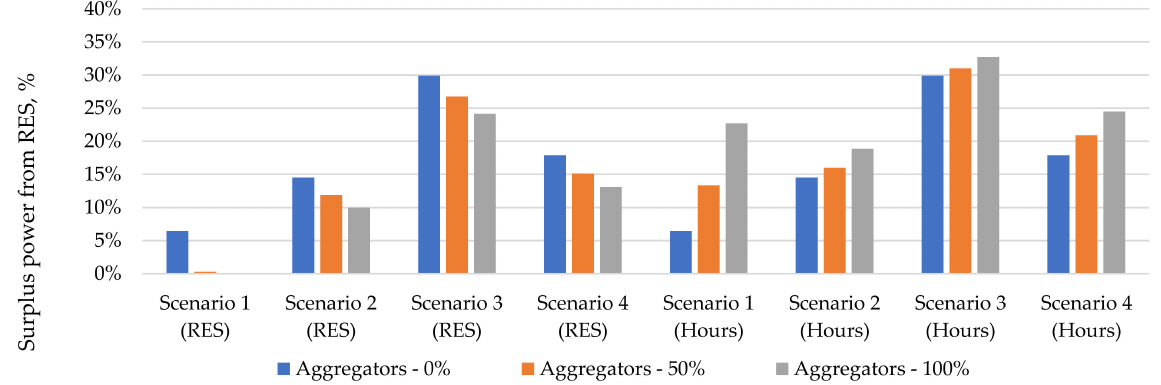
Figure 18. RES surplus power and RES capacity ratio for different aggregator scenarios.